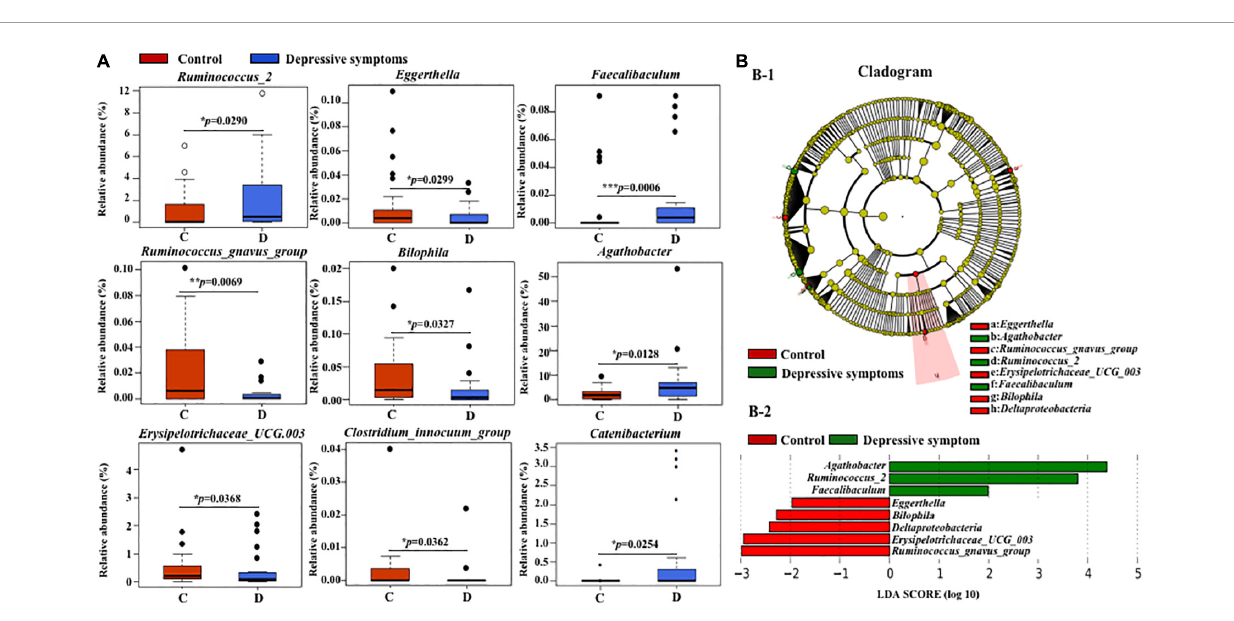
FIGURE5 Boxplots of relative abundance of several genera with a significant difference in depression symptom and the control groups. (A) Difference of meaningful bacterial taxa in depression symptom and the control groups and (B) in depressive symptom and control groups. (B-1) Taxonomic represents a statistical difference in groups. (B-2) Histogram of the LDA scores for differentially abundant